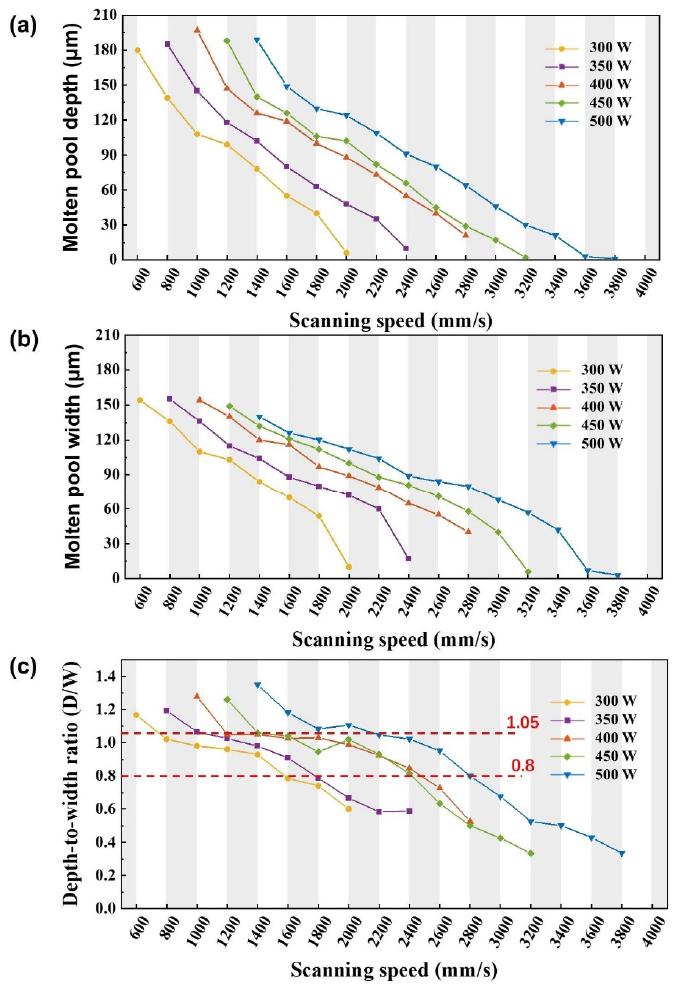
Figure 10. Effects of different process parameters on melt pool geometry: ( a ) depth; ( b ) width; ( c ) depth-to-width ratio.